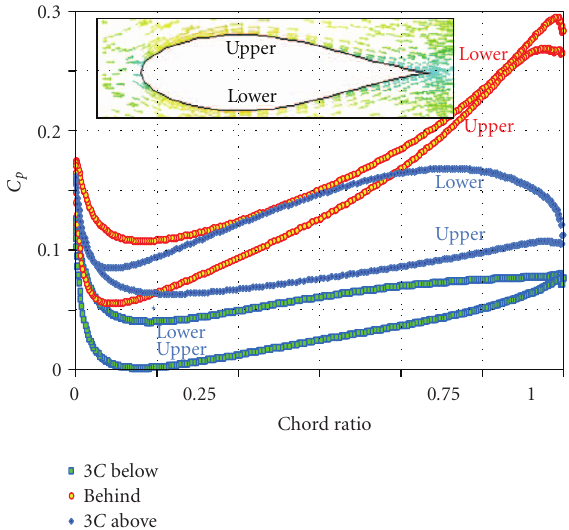
Figure 9: C p values of the airfoil tower at di ff erent rotor positions.